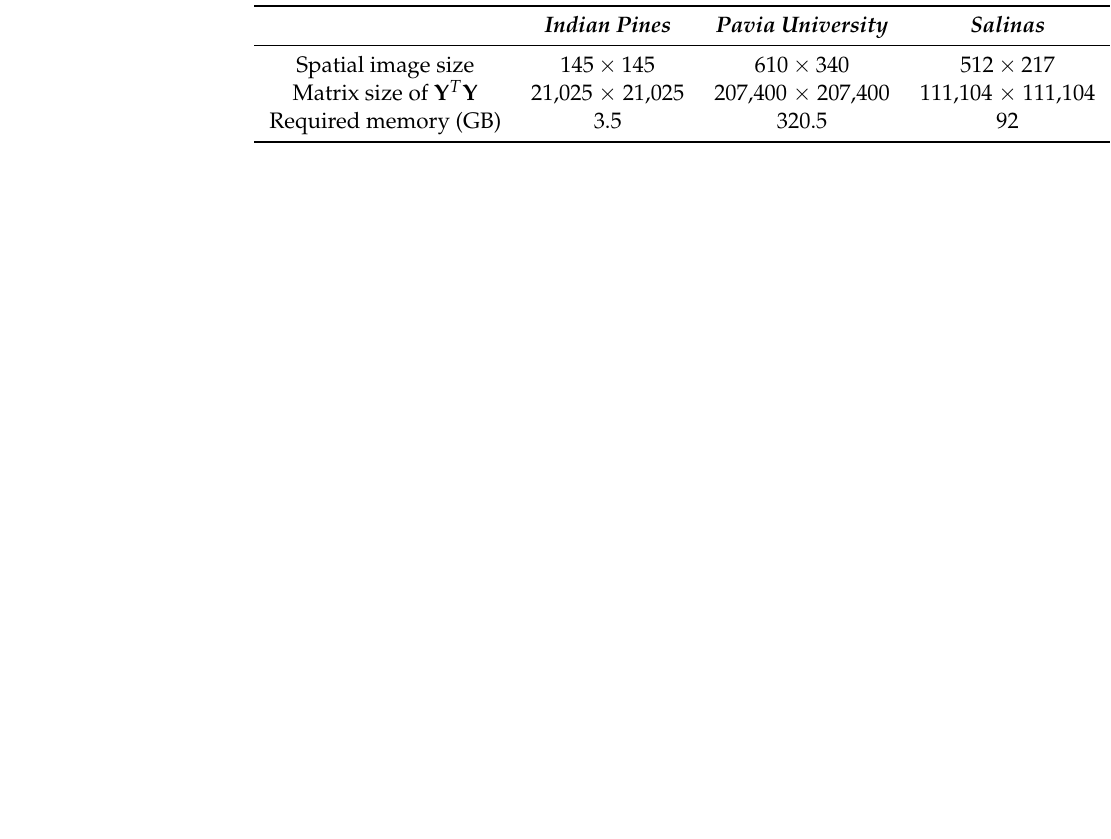
Table 2. Required memory for saving Y T Y in different